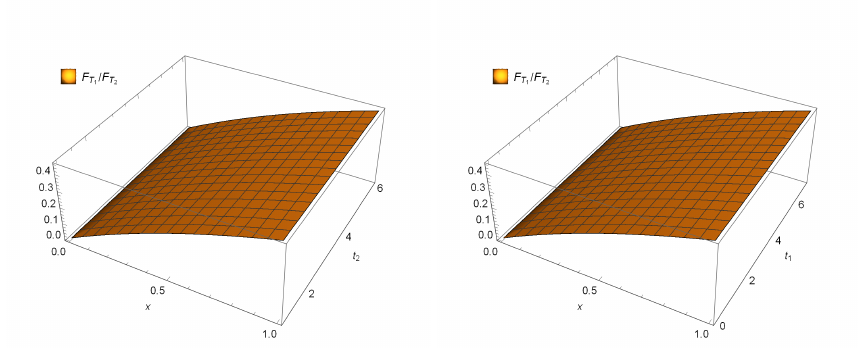
Figure 7. The graphs of the ( F ( RX T 1